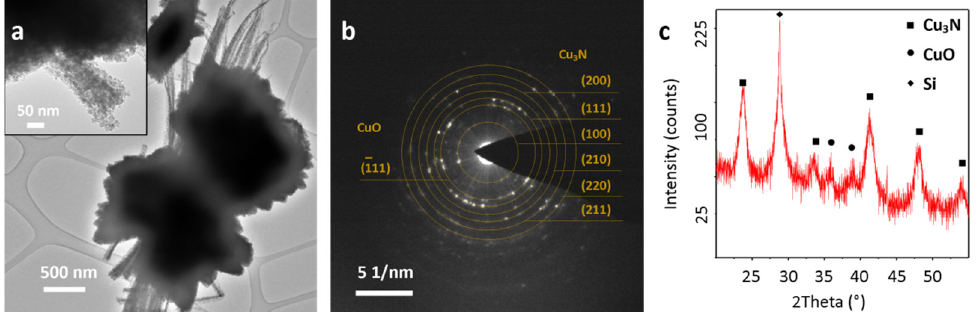
Figure 4. Cu 3 N structure detached from the substrate: ( a ) TEM images, ( b ) SAED pattern of the inset area, ( c ) XRD pattern of Cu 3 N layer.